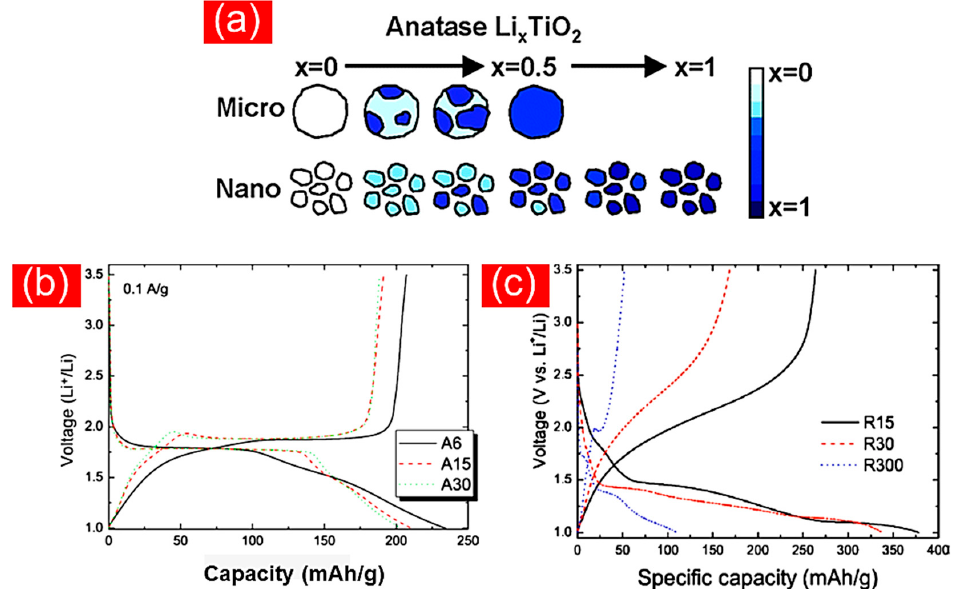
Figure 4. ( a ) Schematic of the impact of particle sizes on the insertion capacity of anatase reprinted with permission from ref. [57]; ( b ) Voltage profile of anatase nanoparticles with 6 (A6), 15 (A15), and 30 (A30) nm in diameter, adapted with permission from ref. [58]; ( c ) The initial capacity profiles of rutile nanoparticles with 15 (R15), 30 (R30), and 300 (R300) nm in diameter, adapted with permission from ref. [65].